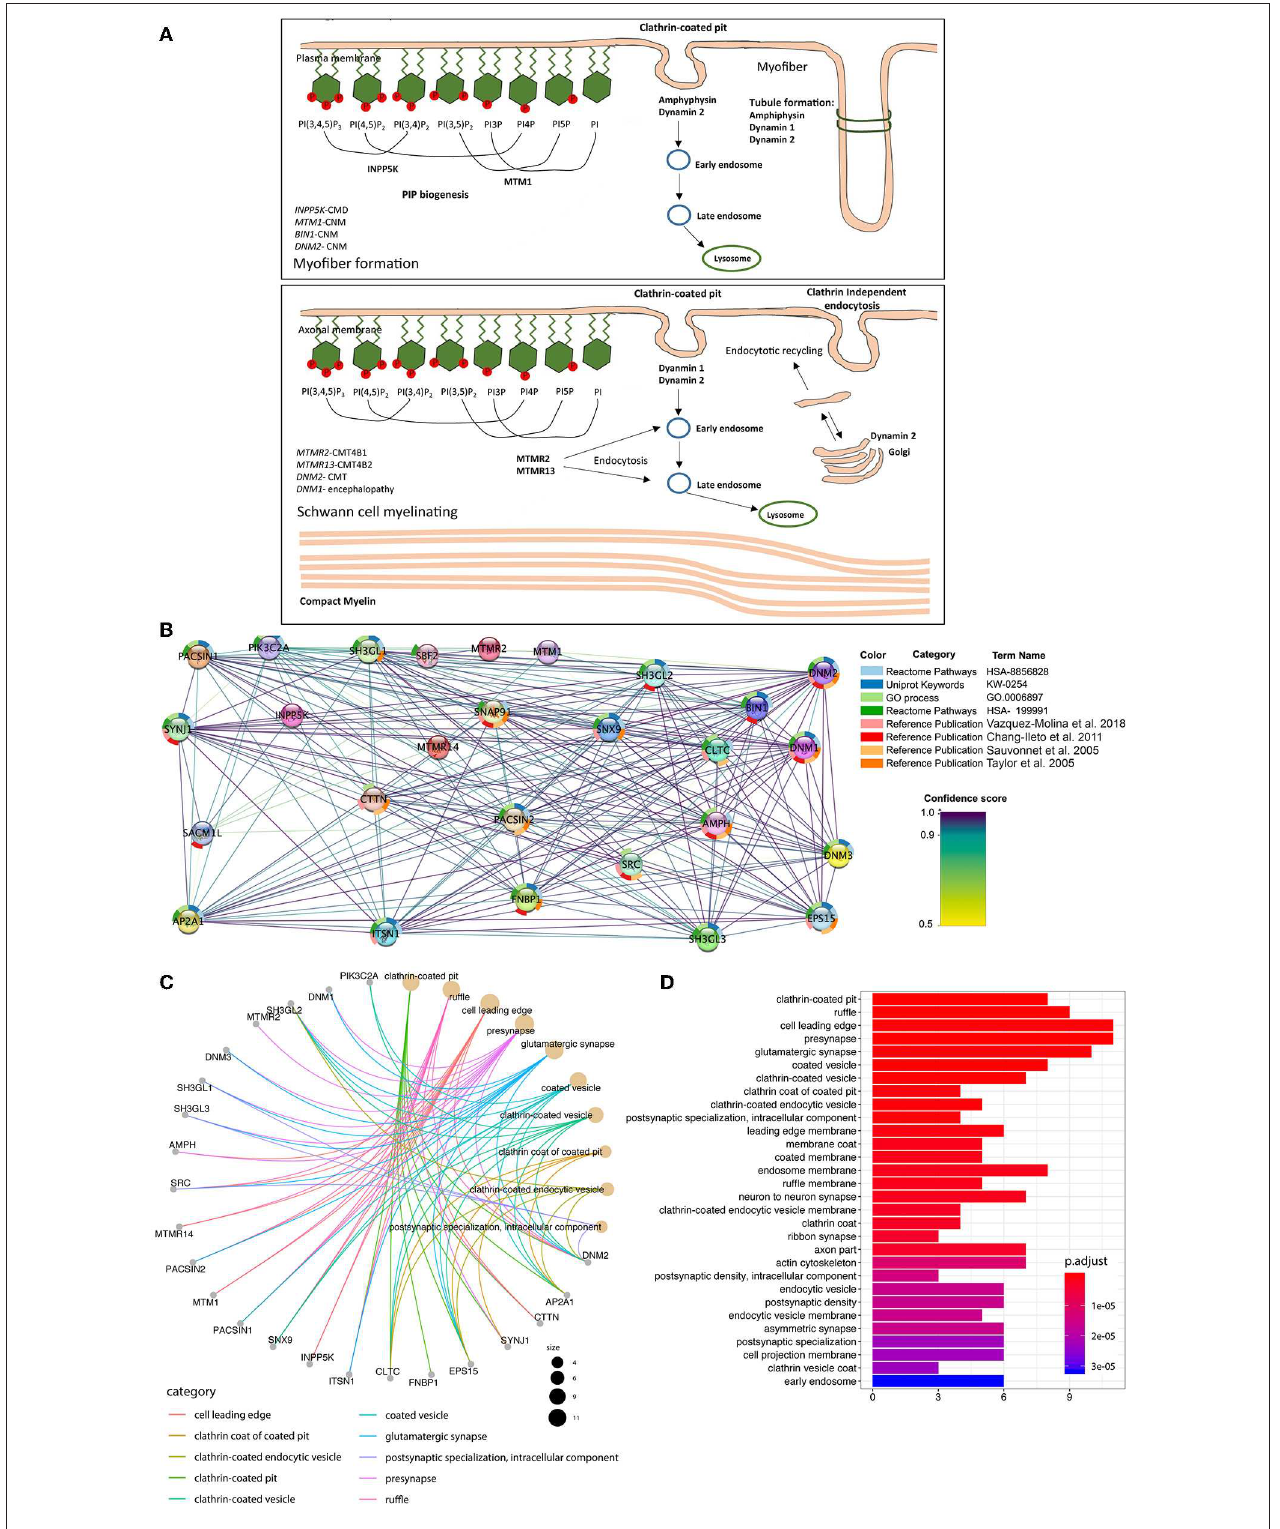
FIGURE 4 | Illustration of neuromuscular disease-associated proteins involved in membrane remodeling. A high resolution figure can be found and downloaded together with the Supplementary Material file. (A) The summarized known genes involved in both myopathy and neuropathy, which encode essential proteins for phosphoinositides equilibrium, membrane remodeling and trafficking based on previous studies (Berger et al., 2006; Cowling et al., 2012). Proteins are classified